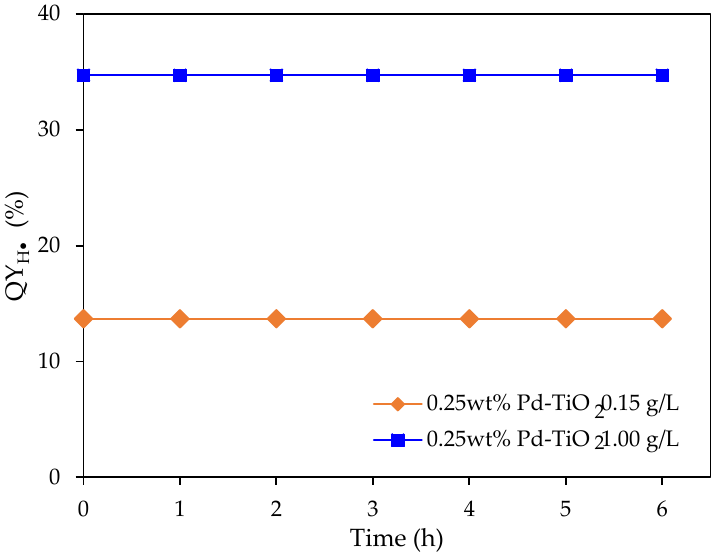
Figure 13. QY H • % at various irradiation times under near-UV irradiation using 0.15 and 1.00 g L − 1 photocatalyst concentrations. Note: 0.25 wt% Pd on TiO 2 ; 2.0% v / v ethanol. Initial pH = 4 ± 0.05.